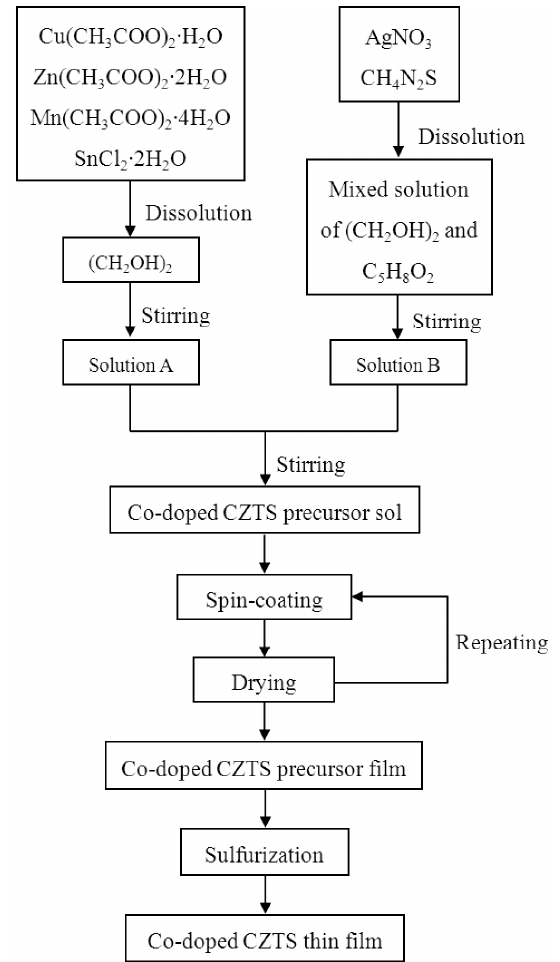
Figure 1. Flow chart for the fabrication process of Ag and Mn co-doped Cu 2 ZnSnS 4 thin films.